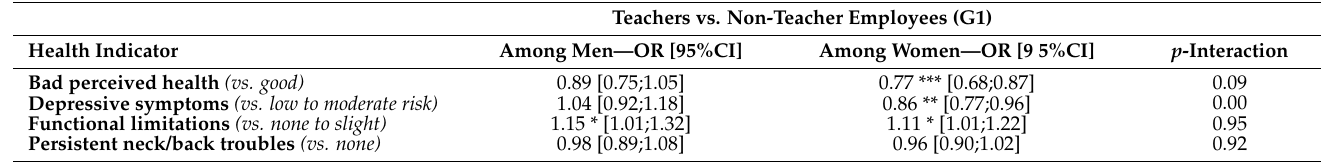
Table 4. Gender stratification and interaction between gender and teaching occupation on health indicators, ESTER-CONSTANCES